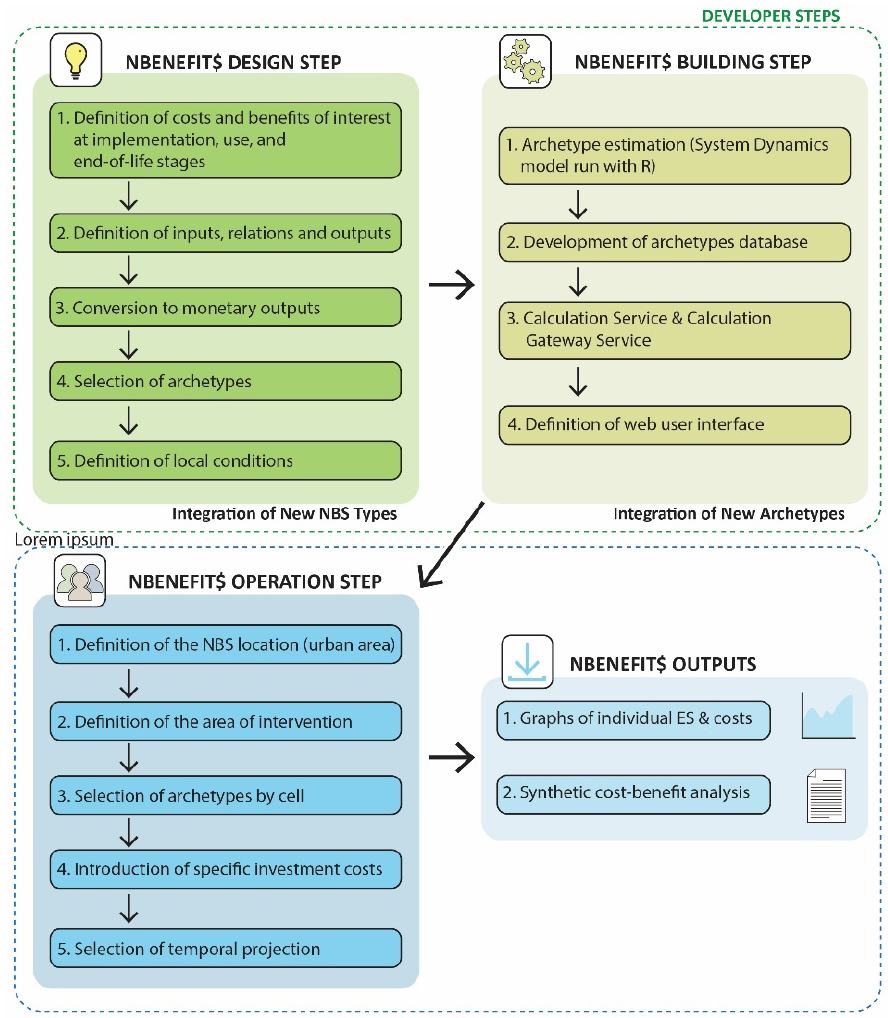
Figure 2. Schematic diagram of the design, building, and operation steps characterising NBenefit$.